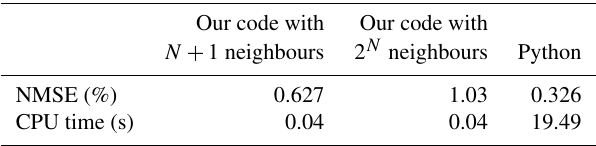
Table 3. Comparison of performance between our code for a 3- D case with the grid data Python library. Machine 2 is used (Ap- pendix